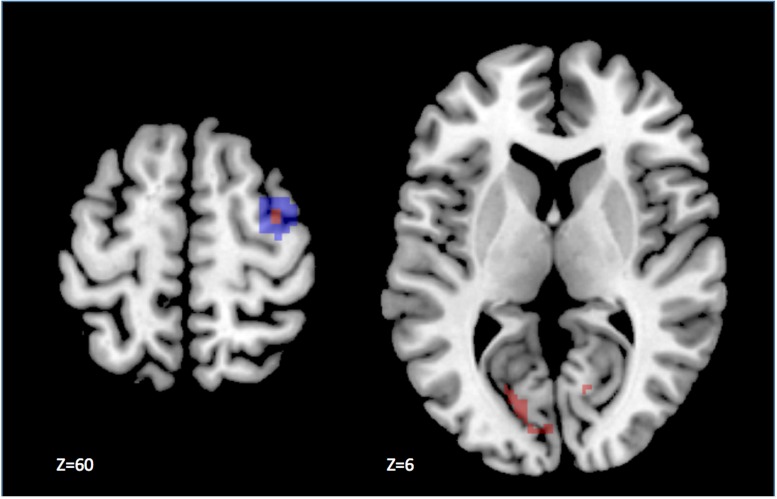
Results of the univariate analysis contrasting large and small saccade blocks. The statistical parametric map has been thresholded at p < 0.05 corrected for multiple comparisons. The difference in activity is significantly larger during the execution of saccades of large amplitude, as compared to small in a few voxels (in red) located in the dorsal part of the anatomical right FEF ROI (highlighted in blue), displayed on the left panel. In addition, we observed activation outside our ROIs, notably in the visual cortex as shown on the right panel.